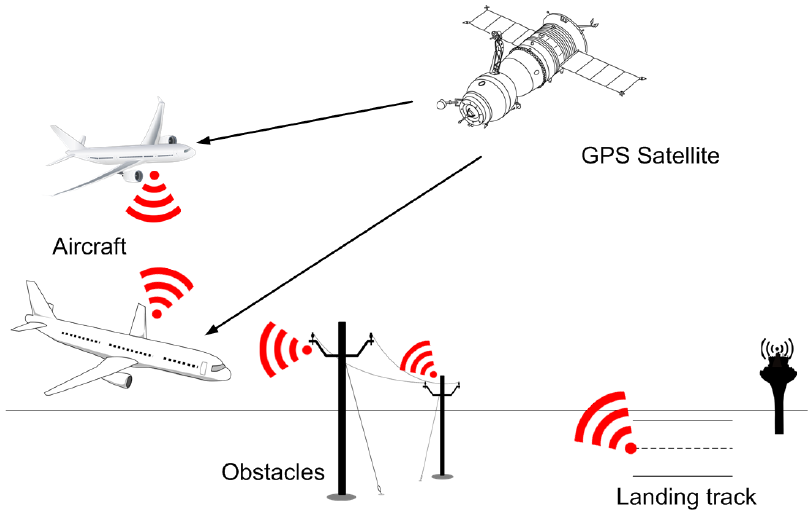
Figure 12. Adaptation of the original ADS-B (Automatic Dependent Surveillance-Broadcast) diagram to the designed proposal.